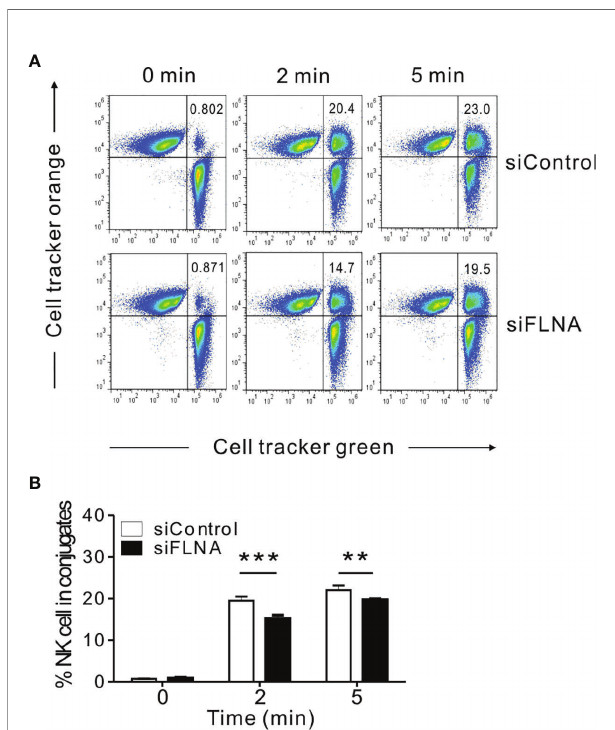
FIGURE 4 | FLNa is required for conjugate formation between NK and target cells. (A, B) NKL cells nucleofected with control or FLNa-speci fi c siRNAs were loaded with Cell tracker green and incubated with Cell tracker orange- labeled 721.221 target cells at an E:T ratio of 1:1 for the indicated times. Thereafter, the cells were fi xed and then analyzed by fl ow cytometry for detecting conjugate formation, as assessed by the double-positive population (upper right quadrant). Shown are representative results (A) and a summary graph (B) . Error bars represent the SD; ** P < 0.01, *** P < 0.001. Results are representative of three independent experiments.